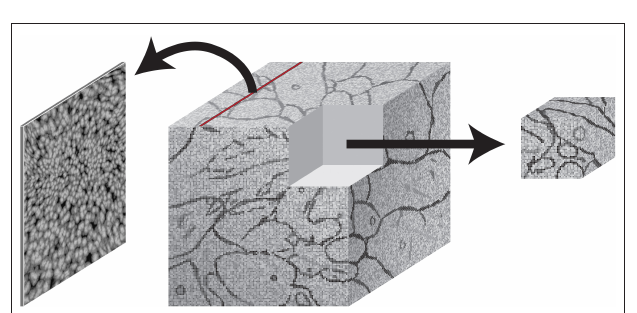
FIGURE 2 | An illustration showing image slices (left) being composed into 3D cuboid volumes (middle). Arbitrary requests may be made to extract image regions of interest (right).